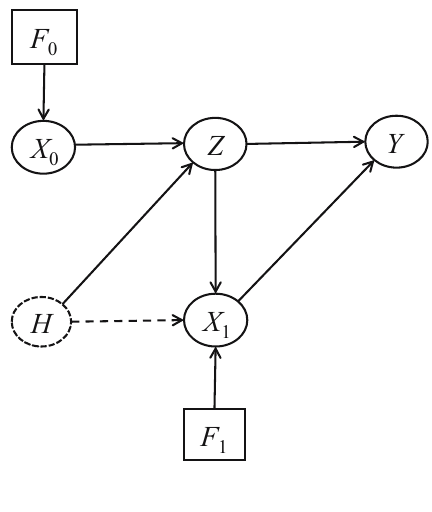
Figure 12: Augmented